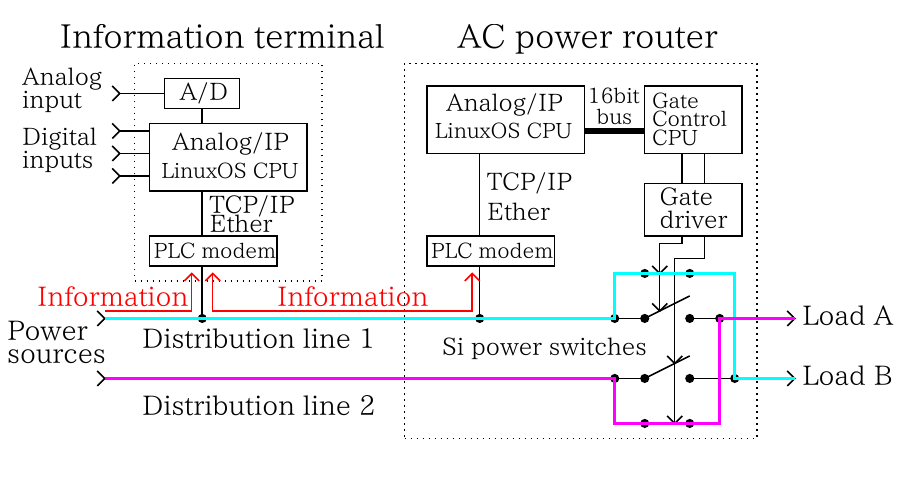
Figure 2. Schematic diagram of AC power routing system.